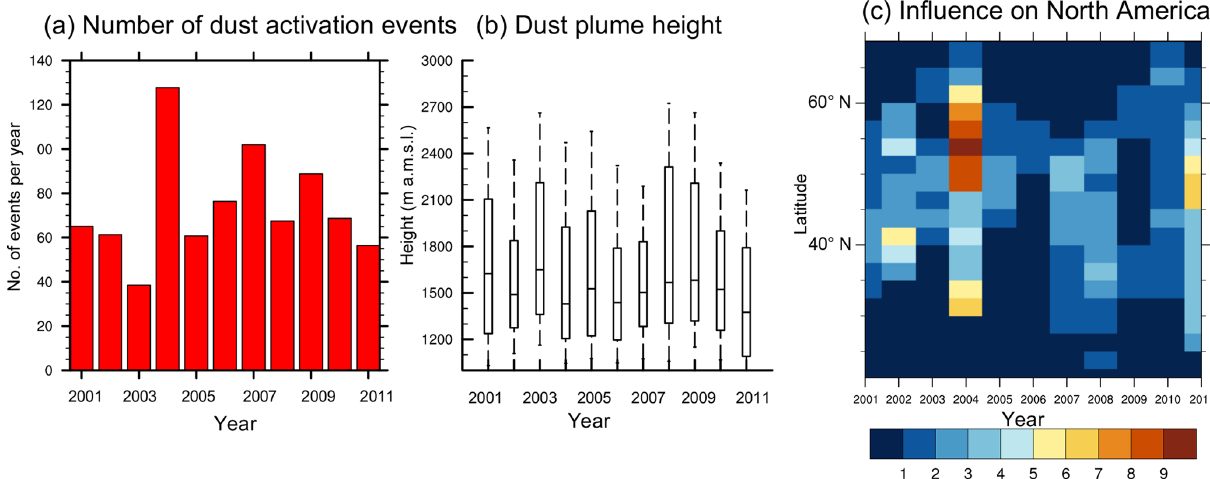
Figure 11. Interannual variability in Taklamakan dust activation and transport during 2001–2011. (a) Dust activation occurrence, (b) dust plume height box plot (10th, 25th, 50th, 75th, and 90th percentiles), and (c) percentage of trajectories passing over North America by